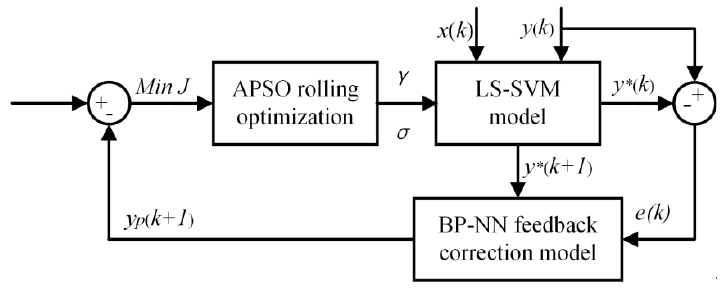
Figure 6. Predictive control model based on APSO LSSVM and BPNN.